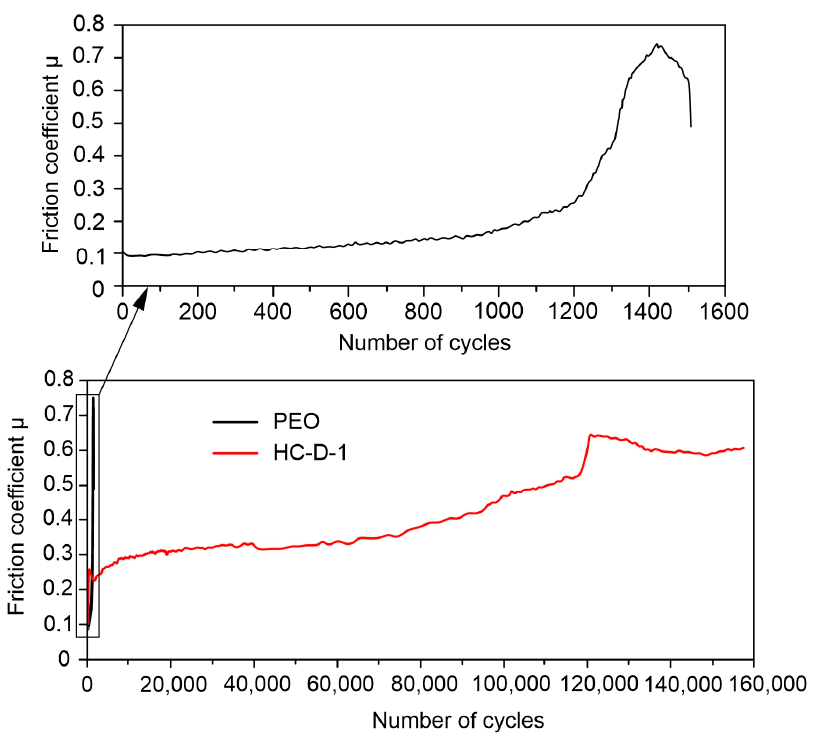
Figure 13. Dependence of the friction coefficient on the number of cycles for samples with different surface treatment. Table 4. The results of tribological tests.